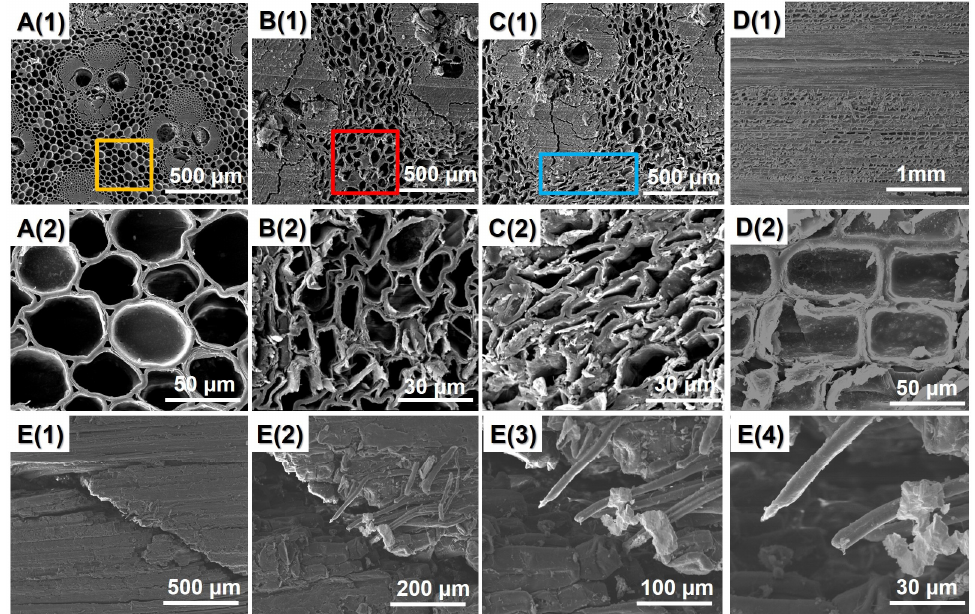
Figure 4. SEM images of different bamboo samples: A(1,2) untreated bamboo sample; B(1,2) softened treated bamboo samples (180 °C/8 min); C(1,2) flattened bamboo board at 180 °C/8 min; D(1,2) : tangential section images of untreated bamboo samples; E(1–4) tangential section images of flattened bamboo board.